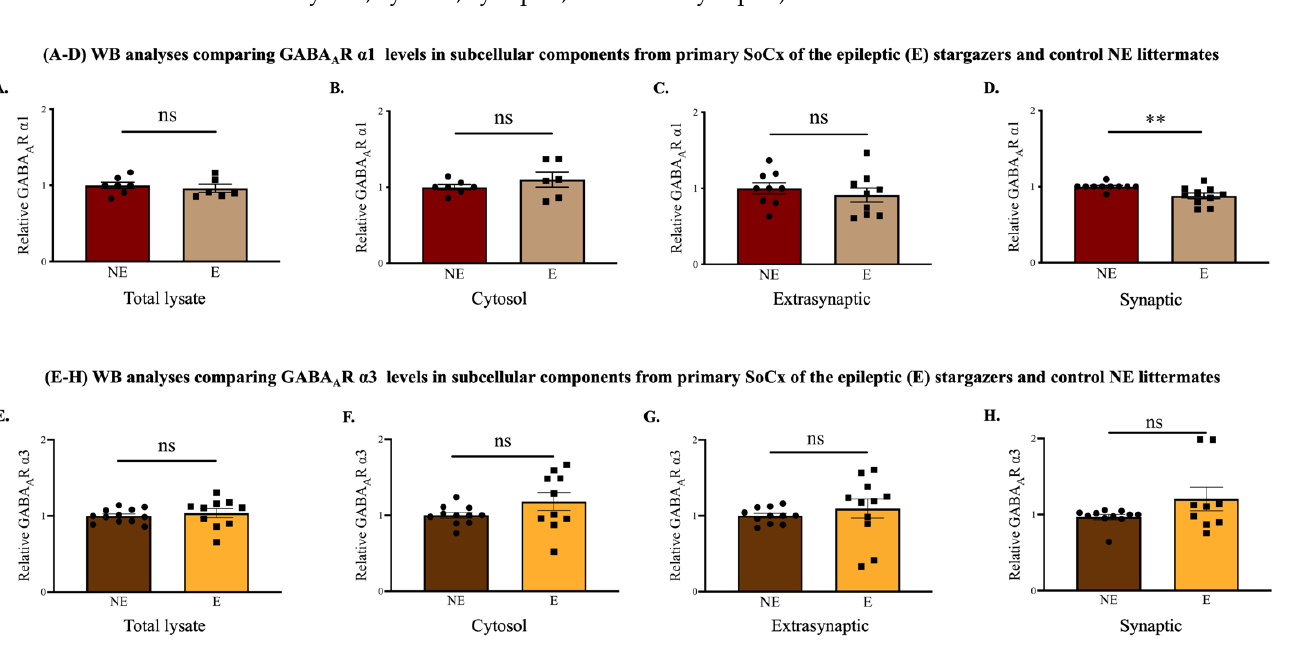
Figure 7. WB analyses of biochemically isolated fractions from the primary SoCx for GABA A R α1 and α3 subunits. Isolated subcellular fractions were compared between control (NE) littermates and epileptic (E) stargazers. ( A − D ) Biochemical fractionation analysis revealed a 12.2% reduction in the synaptic expression of phasic GABA A R α1 in the primary SoCx of the stargazers compared to their control littermates (NE: 1.000 ± 0.146 [ n = 10], E: 0.878 ± 0.037 [ n = 10];